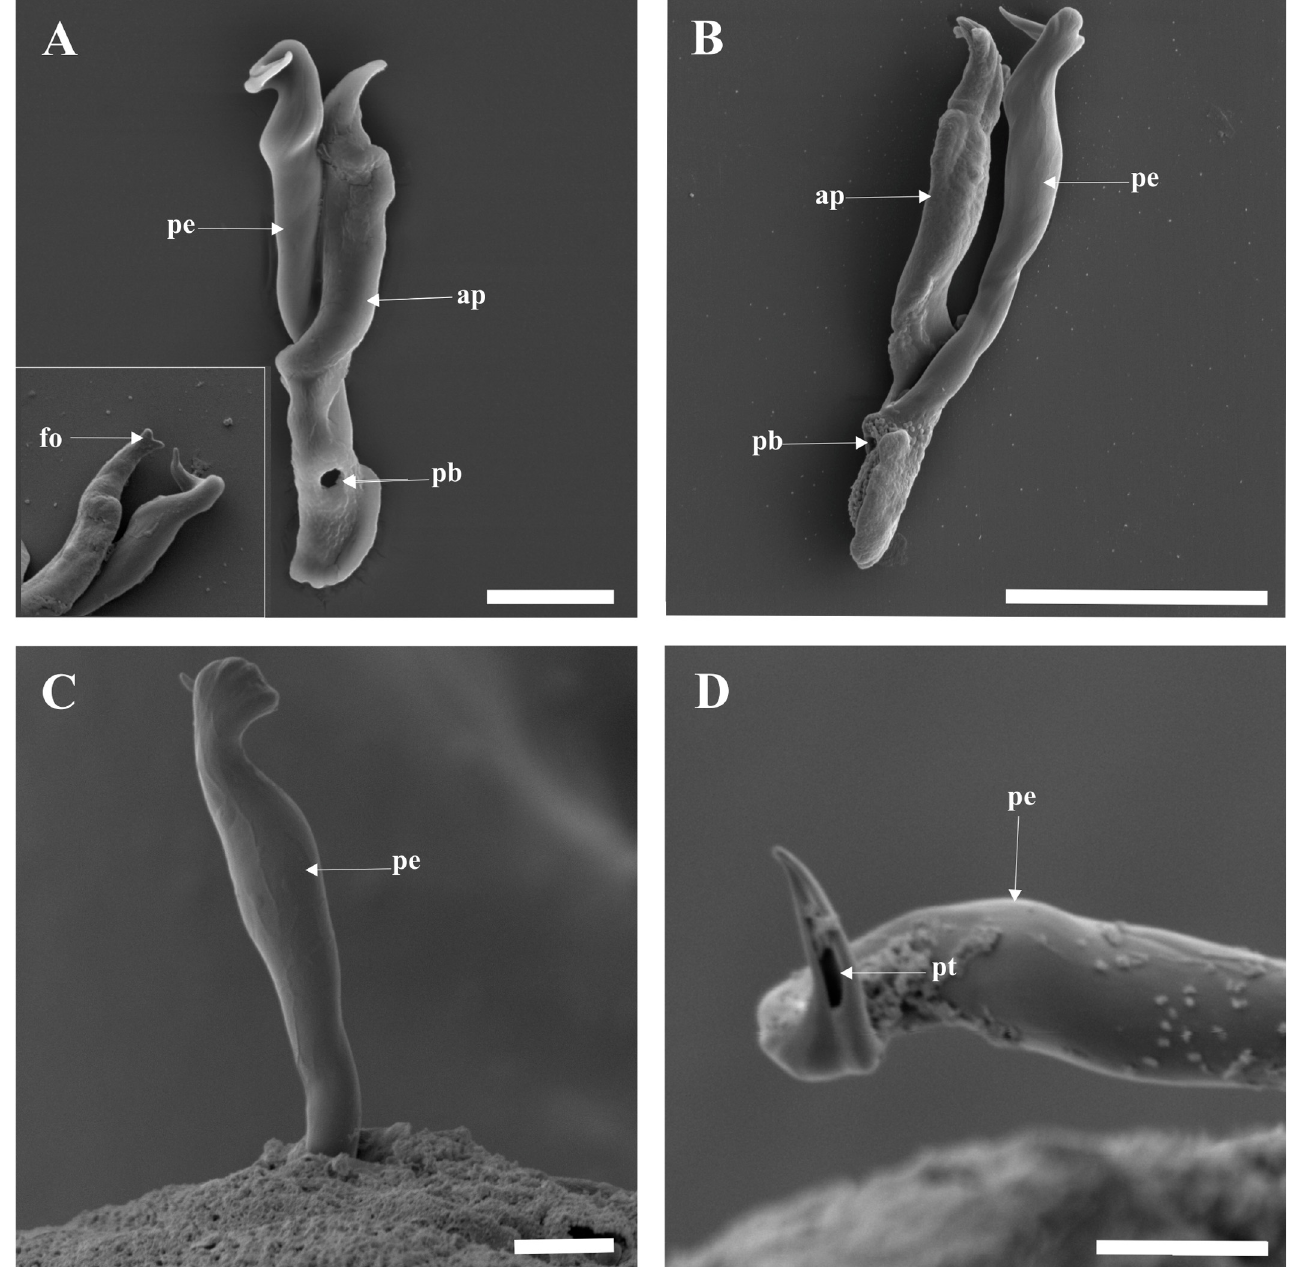
Figure 3. SEM micrographs: A , A insert and B MCO from digested tissue; C MCO within the tissue in lateral view; D peripheral region of MCO in contralateral view, showing opening at tip of penis. Abbreviations: ap accessory piece; fo forked terminal end of accessory piece; pe penis; pt opening at tip of penis; pb opening at base of penis. Scale-bars: A, A insert, 10 m m; B, 20 m m; C-D, 5 m